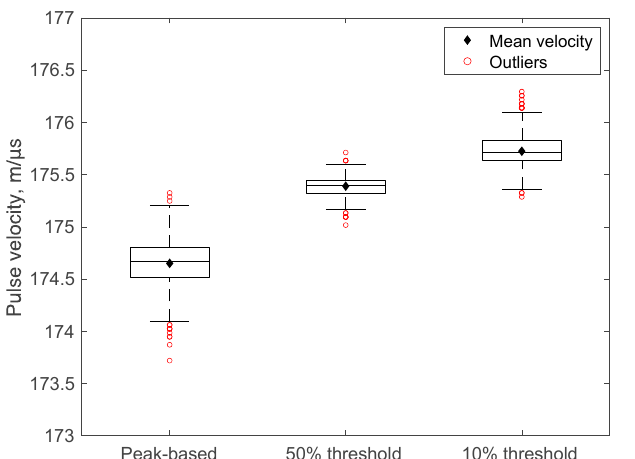
Figure 6. Pulse velocity box plots for 1 nC pulse injected at the far end of the cable, measured using HFCT.